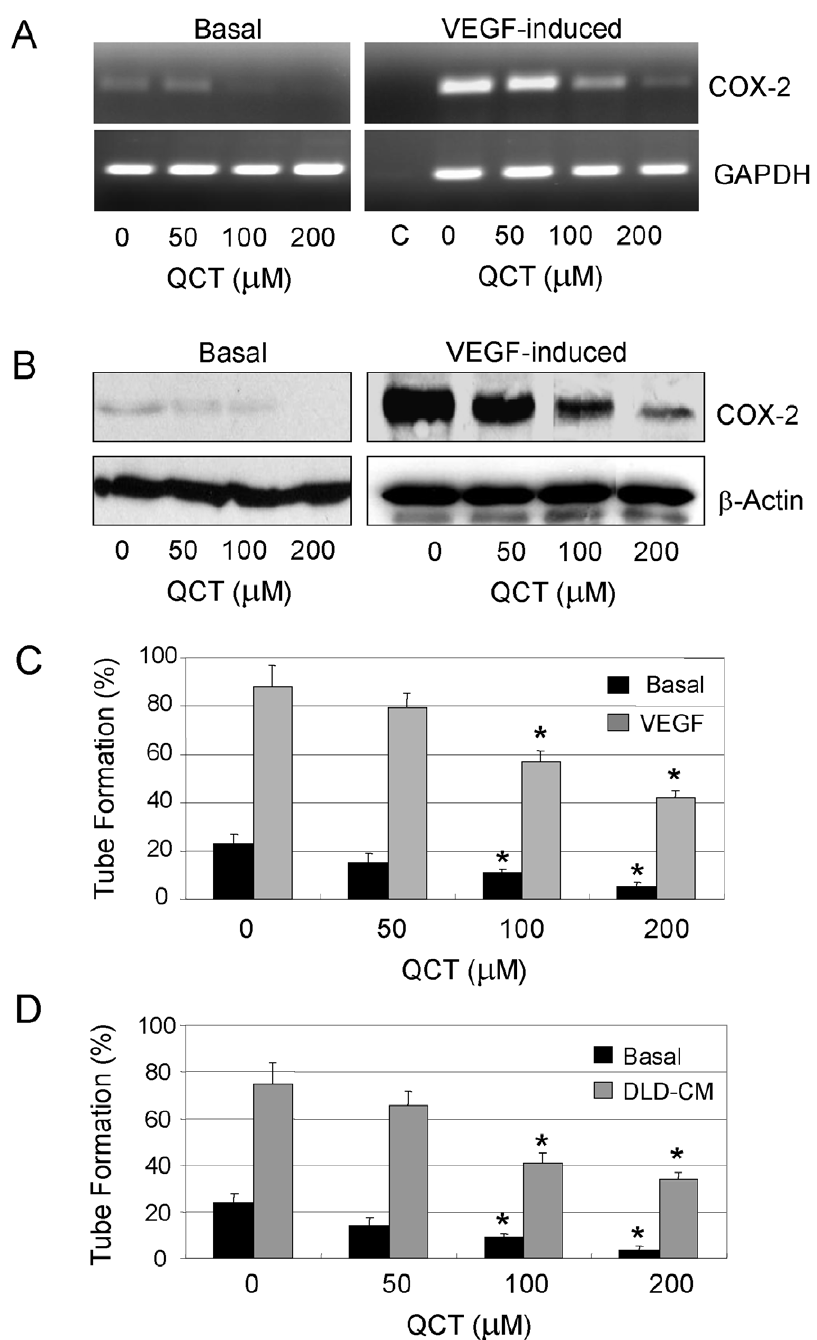
Figure 3. Quercetin inhibited endothelial tube formation. The HUVEC cells were plated in six-well plates pre-coated with growth factor- reduced Matrigel and treated with quercetin together with VEGF165 (10 ng/ml) or DLD-1 cancer cell medium and incubated at 37 u C for 4 h and 24 h. COX-2 mRNA ( A ) and protein ( B ) were analyzed by RT-PCR and Western blotting, respectively. HUVEC tube formation was counted by phase-contrast photographs. Mean values of tube formation on growth factor-rich Matrigel induced by VEGF165 ( C ) and DLD-1 conditioned medium ( D ) were calculated from three separate experiments. The data are presented as mean 6 SD of three separate experiments. *, P , 0.05, significant differences between treatment groups and control groups. C, PCR control; Basal, medium-treated cells as negative control.